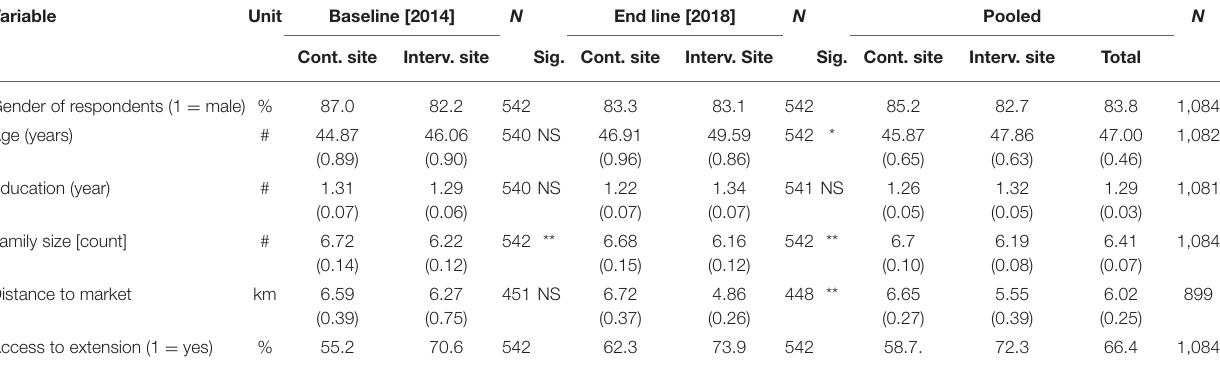
TABLE 3 | Summary statistics of sample households by survey period and treatment status.